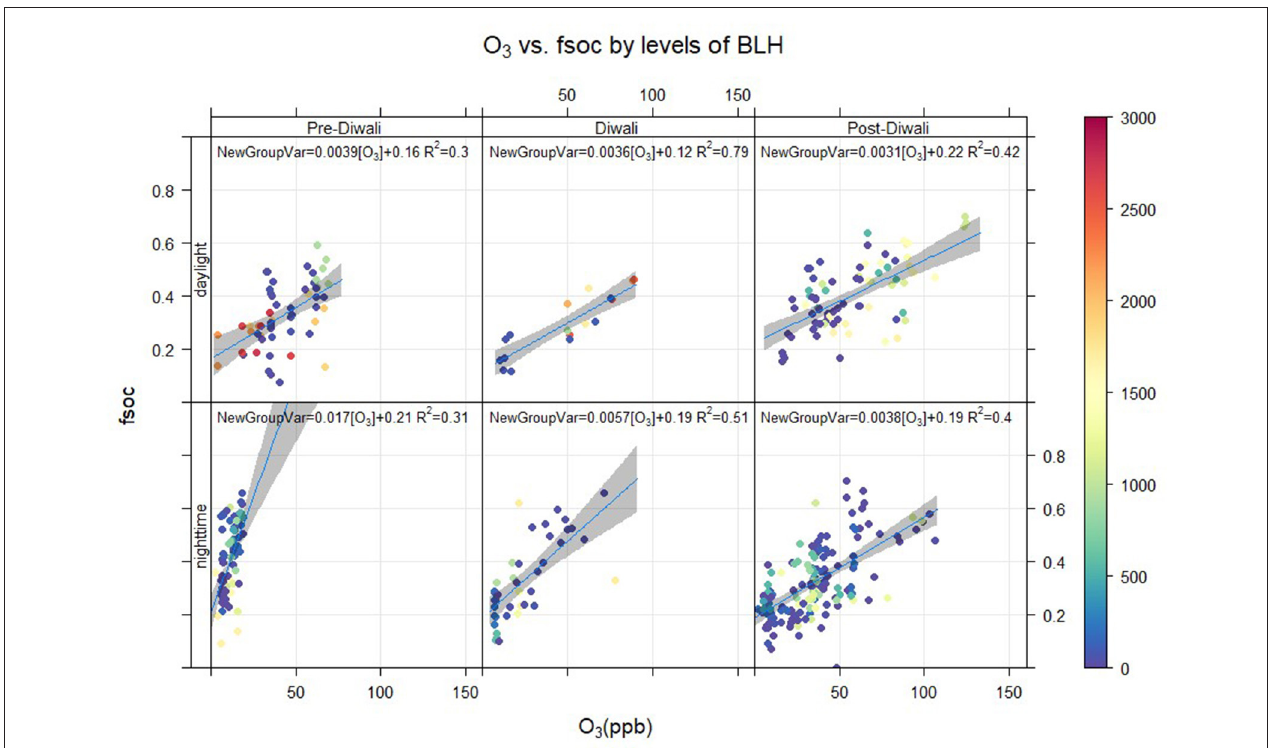
FIGURE 7 | Linear regression analysis of f soc ( = SOC/OC) against O 3 (ppb) by levels of BLH (m) in day and nighttime during Pre-Diwali, Diwali and Post-Diwali periods.